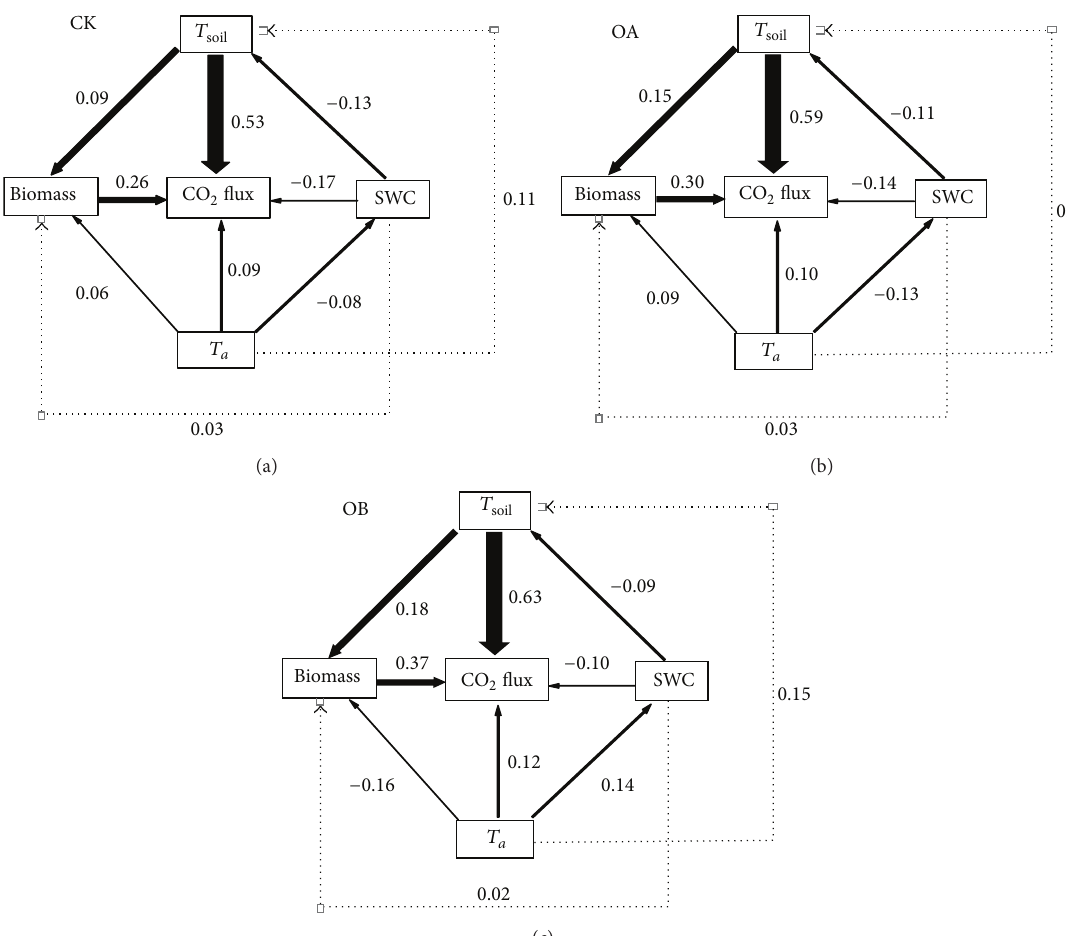
Figure 7: Path diagrams showing the effects of air temperature ( 𝑇 𝑎 ), 5 cm depth soil temperature ( 𝑇 soil ), 5 cm depth soil water content (SWC), andplantbiomass(biomass)onecosystemCO 2 efflux(CO 2 flux)duringthegrowingseasoninplotCK(a),OA(b),andOB(c).Thethicknesses of the arrows and the adjacent values represent the path coefficients. The analysis was based on the daily average values of all